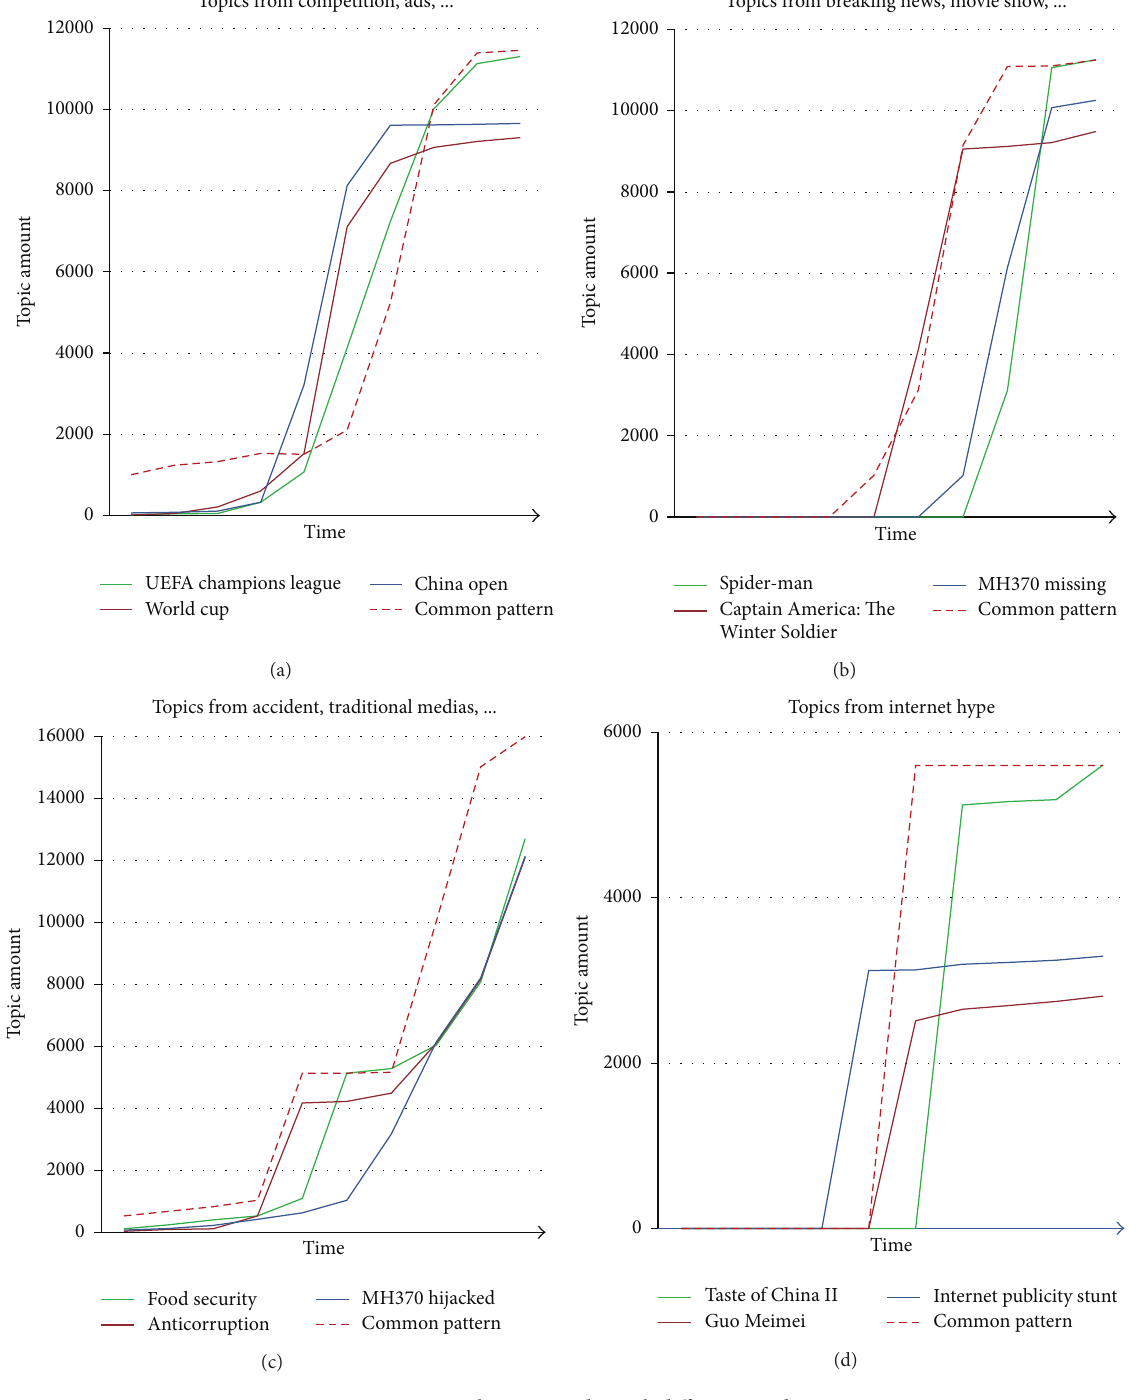
Figure 4: Topic hotness modes with different